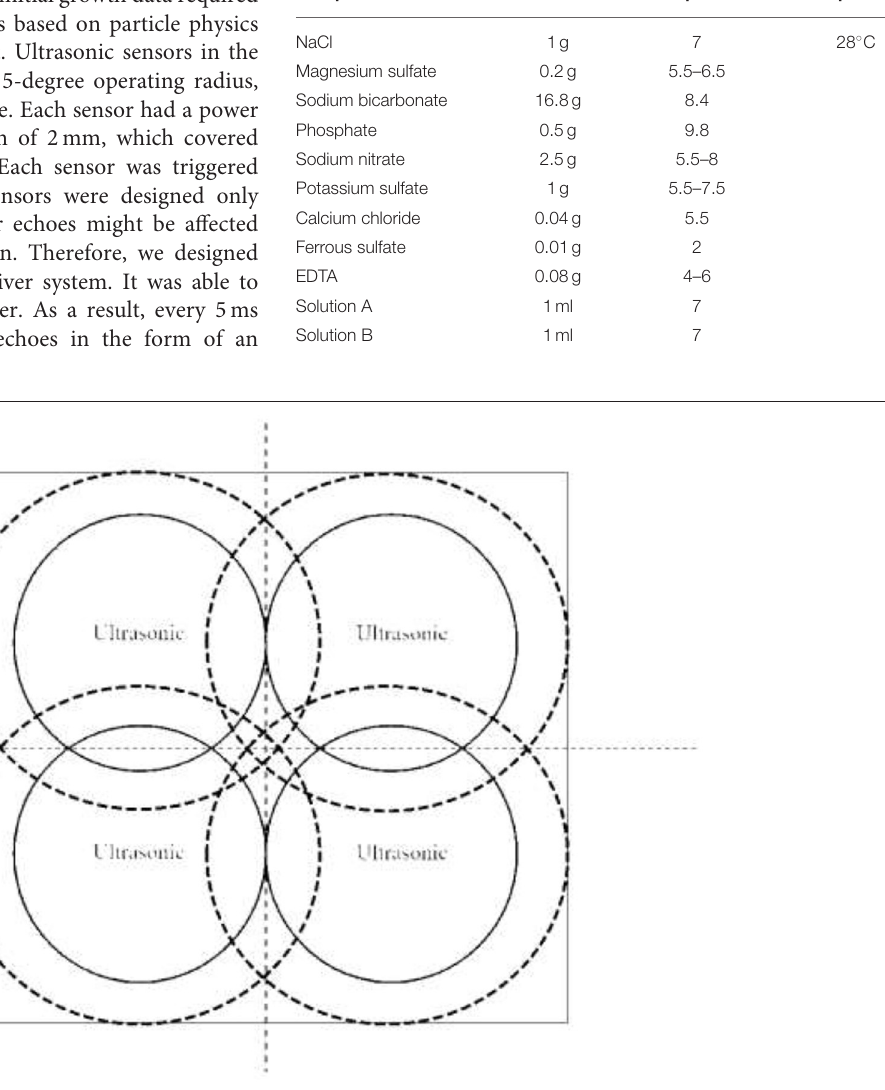
FIGURE 4 | Location of ultrasonics for movement and growth